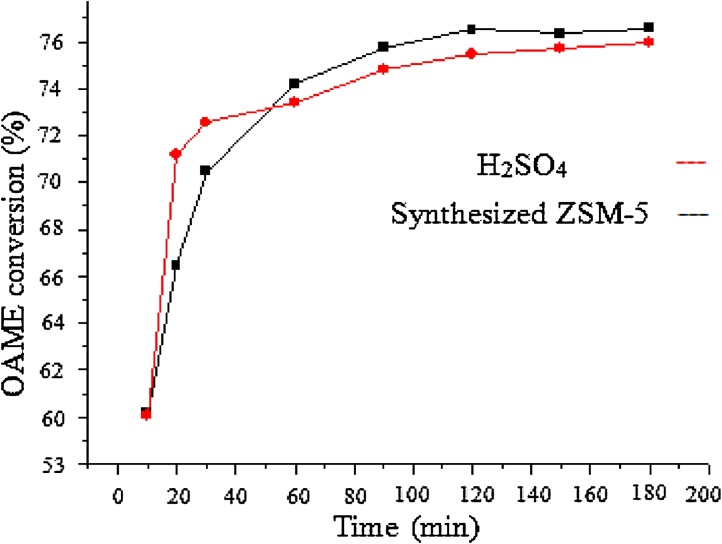
OAME conversions with synthesized ZSM-5 and H2SO4 catalysts.